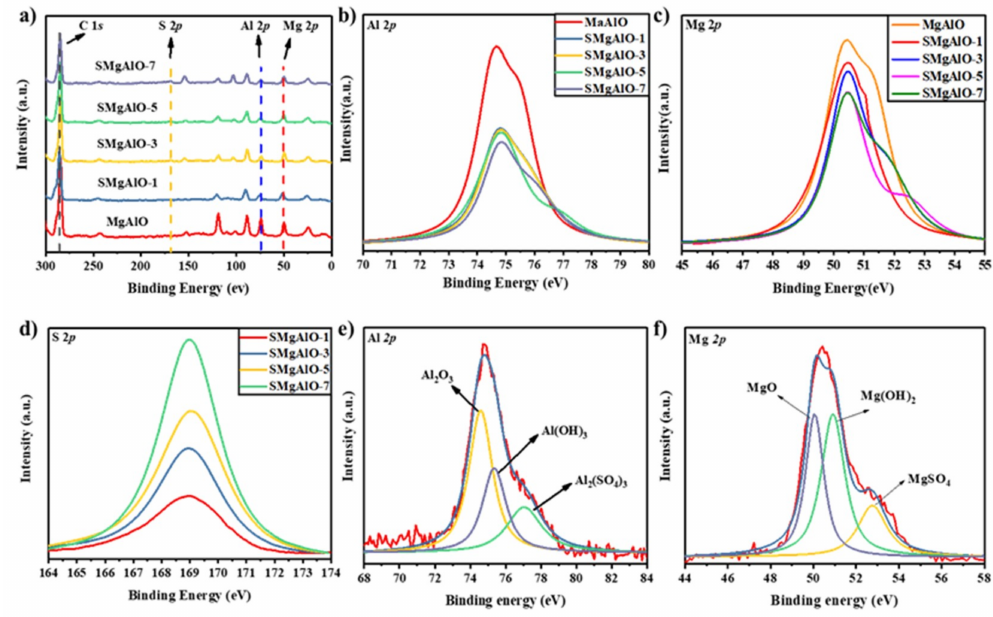
Figure 3. XPS spectra for full scan ( a ), Al 2p for SMgAlO ( b ), Mg 2p for SMgAlO ( c ), S 2p for SMgAlO ( d ), 2p Al for SMgAlO-5 ( e ), and Mg 2p for SMgAlO-5 ( f